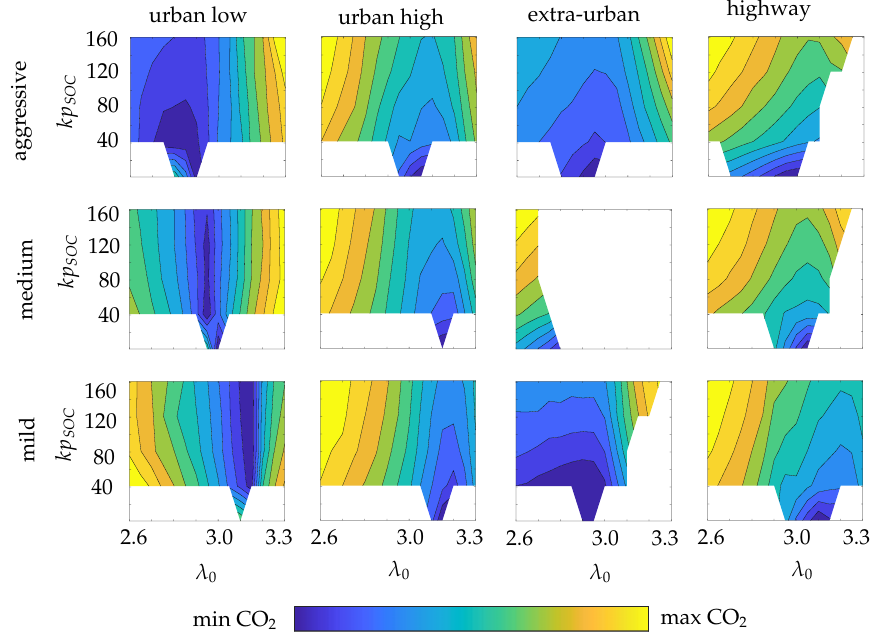
Figure 8. Parameter studies for both kp SOC and λ 0 for Online ECMS (1000 Wh battery). Next, the battery-specific ideal parametrization of the Online ECMS is selected. This parametrization is characterized by the smallest mean deviation from the global optimum over all 12 cycles. Final parameters are listed in Table 4. Along the lines of the Offline ECMS in Section 4.1, the increase in fuel consumption compared to the global optimum (DP solution) decreases with a larger battery (3.41%–>0.88%). Table 4. Final parameters appropriate selection of kp SOC and λ 0 for the Online ECMS.